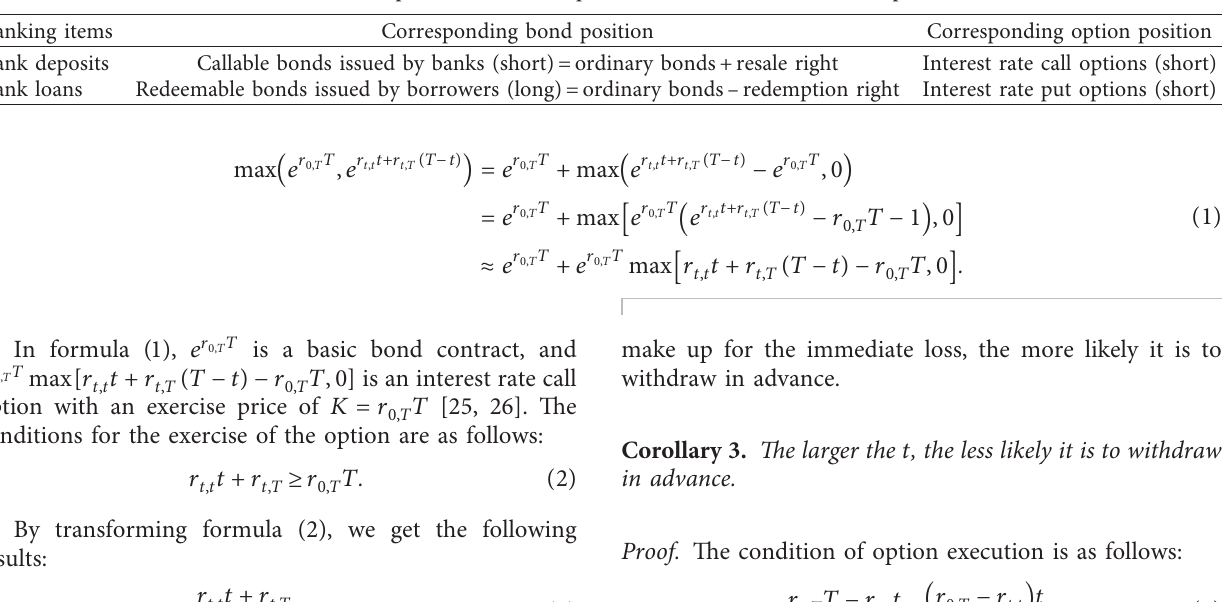
Table 1: Decomposition of bank deposits and loans with embedded